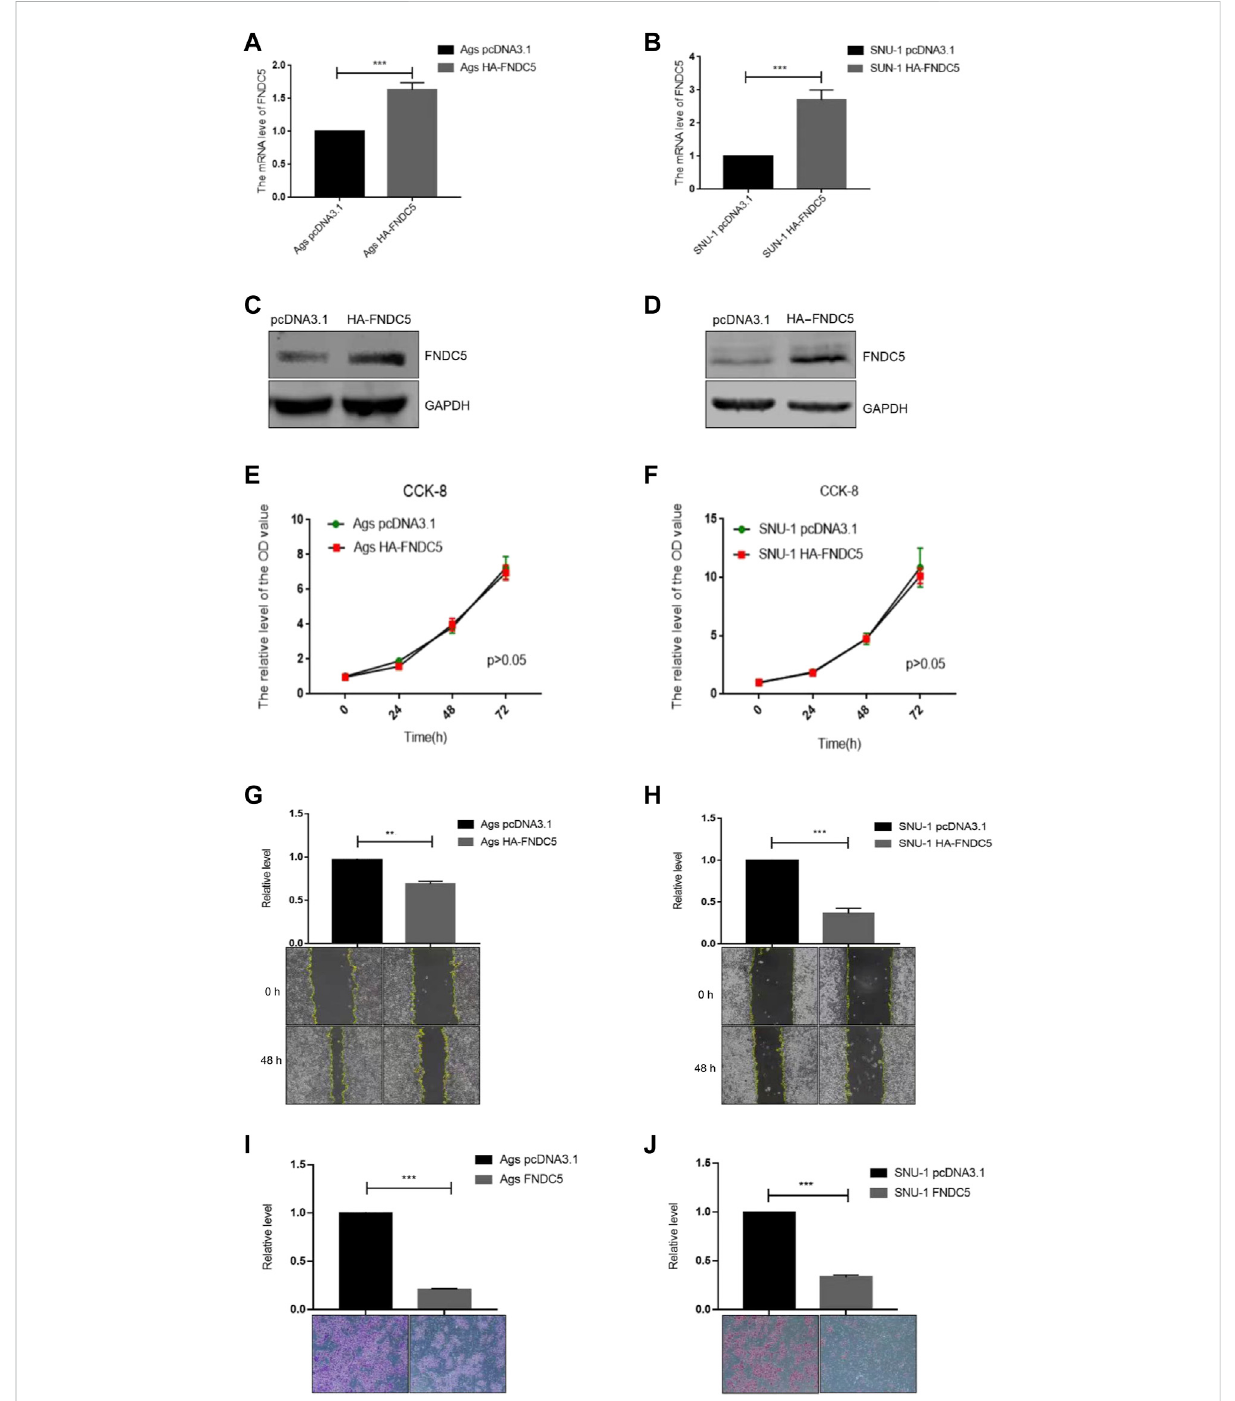
FIGURE 4 Overexpression of FNDC5 inhibited invasion and migration of gastric cancer cells. (A,B) mRNA levels of FNDC5 in Ags and SNU-1 cells were analyzed by overexpression of FNDC5 using RT-PCR. (C,D) Increased protein levels of FNDC5 in Ags and SNU-1 cells transfected with HA-FNDC5 using western blotting. (E,F) Using the CCK-8 assay to assess the impact of FNDC5 on cell growth. (G,H) Elevated expression of FNDC5 inhibits migration of Ags and SNU-1 cells. (I,J) Elevated expression of FNDC5 inhibits the invasion of Ags and SNU-1 cells. **, p < 0.01; ***, p <